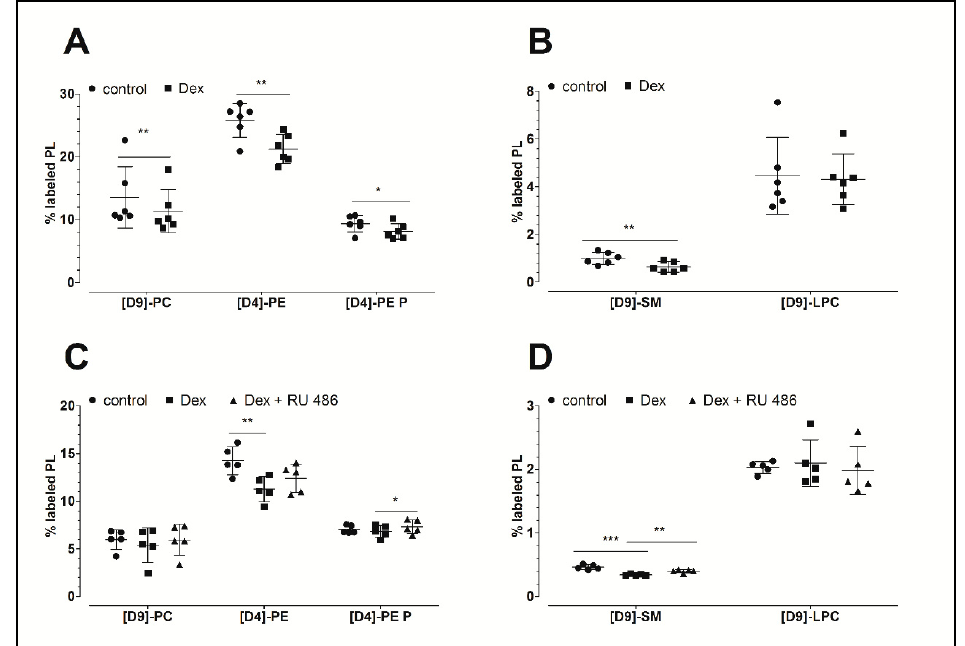
Figure 1. The effect of dexamethasone and RU 486 on the biosynthesis of PLs by human FLS. ( A , B ) The e ff ect of dexamethasone on the biosynthesis of PL classes. The percentages of labeled PL classes from the total corresponding labeled and unlabeled PL classes are presented. FLS were treated with 10 µM dexamethasone (Dex) for 16 h. Data are presented as means ± SDs ( n = 6). ( C , D ) The effect of dexamethasone on the biosynthesis of PL classes as modulated by the glucocorticoid receptor antagonist RU 486. The percentages of labeled PL classes from the total corresponding labeled and unlabeled PL classes are presented. FLS were first pretreated for 30 min with 1 µ M RU 486, and then treated with 10 µ M dexamethasone (Dex) for 16 h in the presence of stable isotope-labeled lipid precursors. Data are presented as means ± SDs ( n = 5). * p ≤ 0.05, ** p ≤ 0.01, *** p ≤ 0.001. PC = phosphatidylcholine; PE = phosphatidylethanolamine; PE P = phosphatidylethanolamine-based plasmalogens; SM = sphingomyelin; LPC =